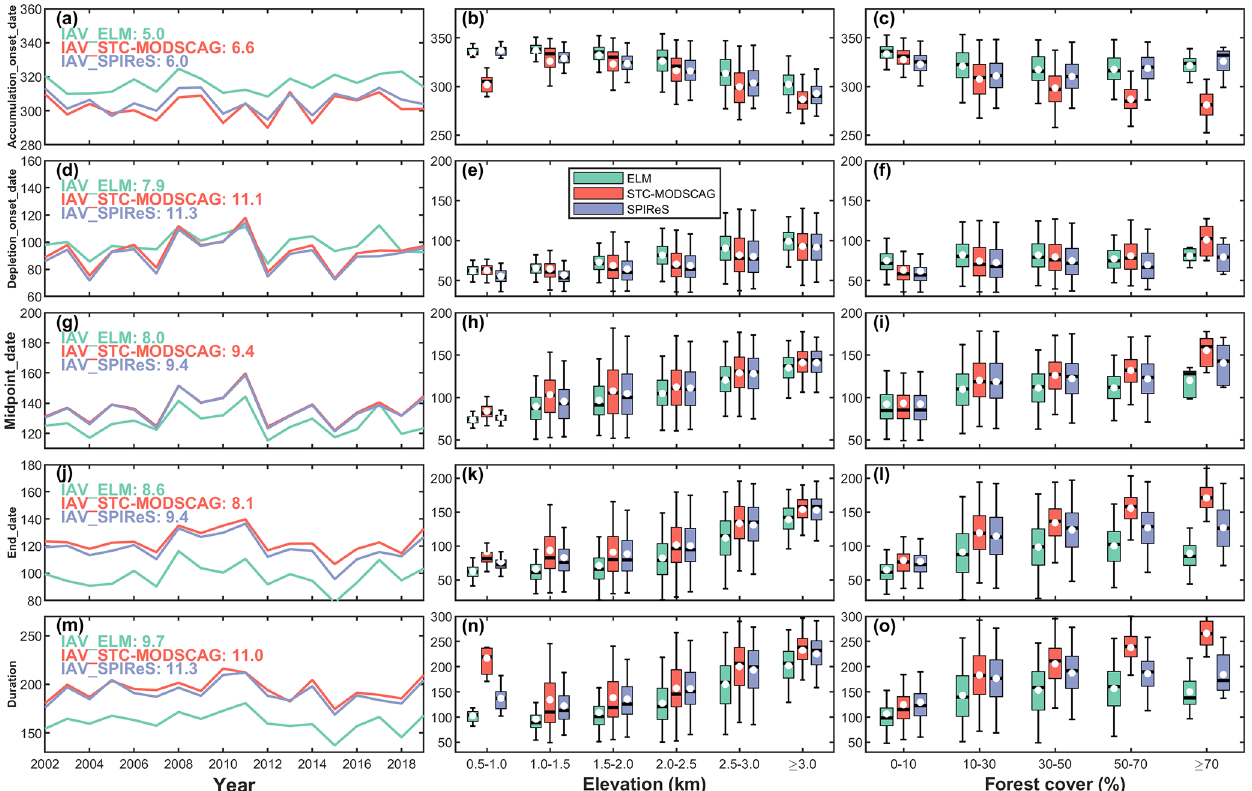
Figure 16. (a, d, g, j, m) Time series of regional average values, (b, e, h, k, n) elevation gradients, and (c, f, i, l, o) change with forest cover of snow timing in ELM and two remote sensing products (i.e., STC-MODSCAG and SPIReS) for different metrics: (a–c) Accumu- lation_onset_date, (d–f) Depletion_onset_date, (g–i) Midpoint_date, (j–l) End_date, and (m–o) Duration over the WUS. The IAV values of different data are shown in (a, d, g, j, m) . In panels (b, c, e, f, h, i, k, l, n, o) , the white dots represent the average values. Table 3. Evaluation of snow phenology in ELM against STC-MODSCAG and SPIReS.